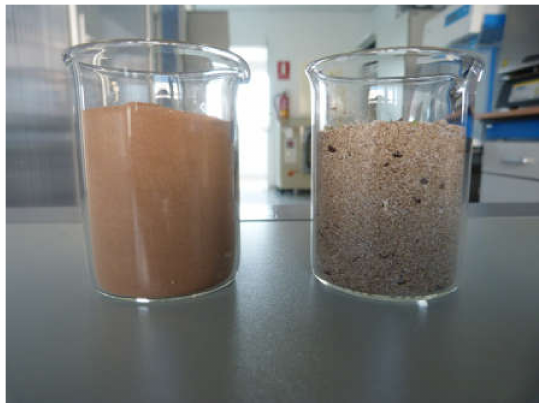
Figure 2. Picture of the two sands employed in the study, from Morocco ( left ) and the United Arab Emirates (UEA) ( right